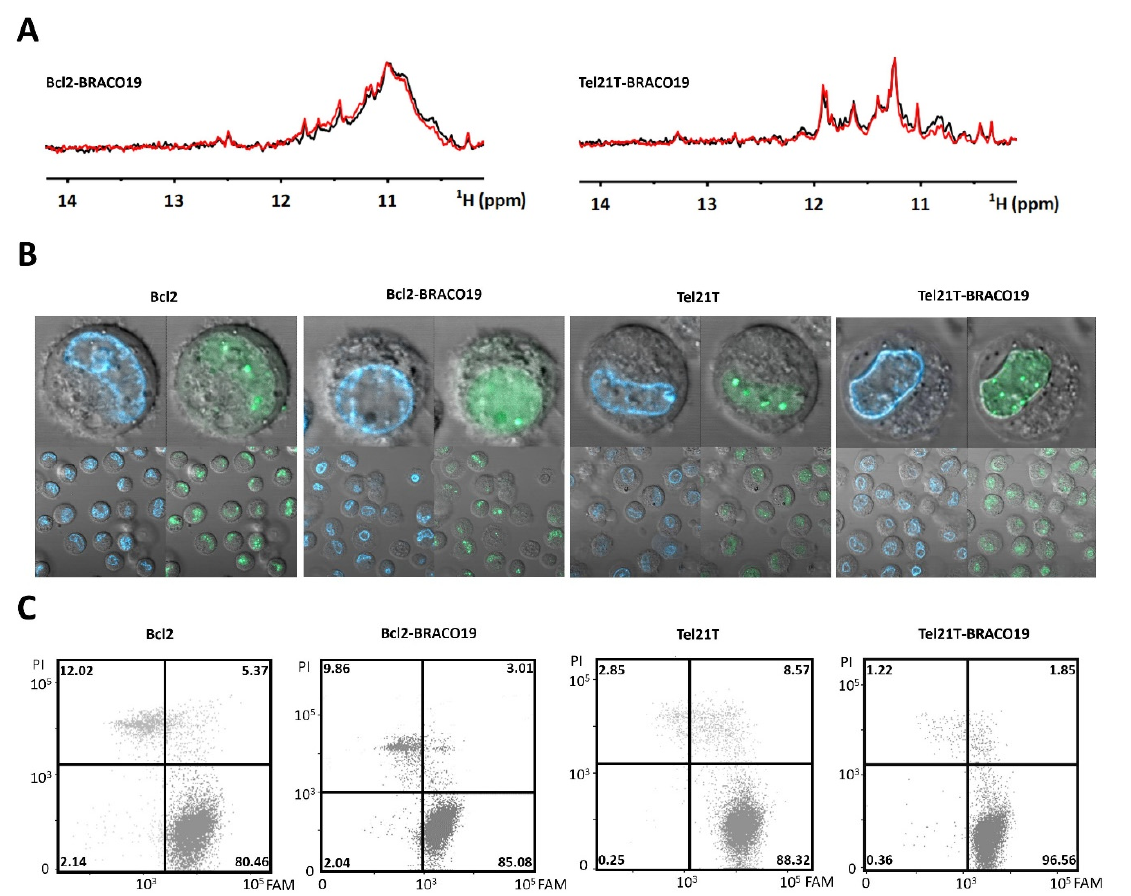
Figure 2. ( A ) Imino regions of 1D 1 H NMR spectra of Bcl2 (left) and Tel21T (right) acquired before (black line) and after (red line) “mock” electroporation in EC buffer. ( B ) Confocal microscopy images taken with 63 × /1.2 C-Apochromat objective of RPE cells transfected with Bcl2, Bcl2–BRACO19, Tel21T, and Tel21T–BRACO19. The green color indicates the localization of (FAM)-DNA/(FAM)-DNA–ligand complex. The blue color corresponds to a cell nucleus stained by Hoechst 33342. ( C ) Double staining (PI/FAM) FCM analysis of transfected RPE cells with the DNA and DNA–ligand complexes. Percentages (the numbers in the FCM plots) of viable non-transfected cells, viable DNA/DNA–ligand containing cells, non-transfected dead/compromised cells, and transfected dead/compromised cells containing DNA/DNA–ligand are indicated in left-bottom, right-bottom, left-top, and right-top quadrants, respectively.